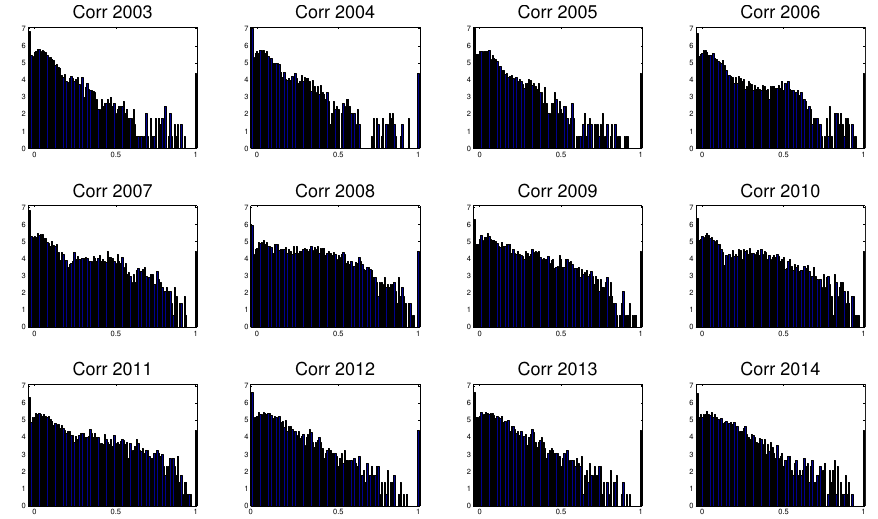
Figure 8. Logarithmic values of frequency distributions of the correlation matrices for each of the years of data for Sector 1 (original × original